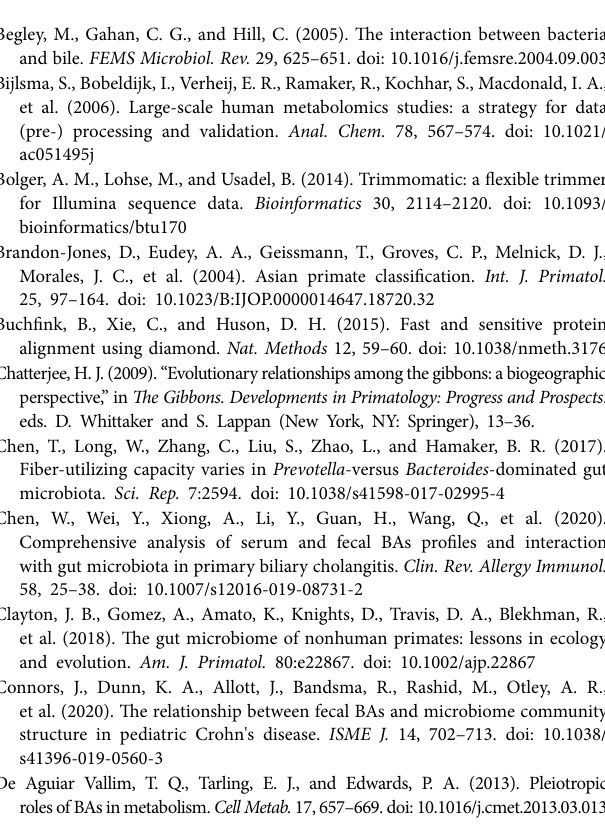
Supplementary Table S1 | Samples information. Supplementary Table S2 | Sample sequencing data evaluation.